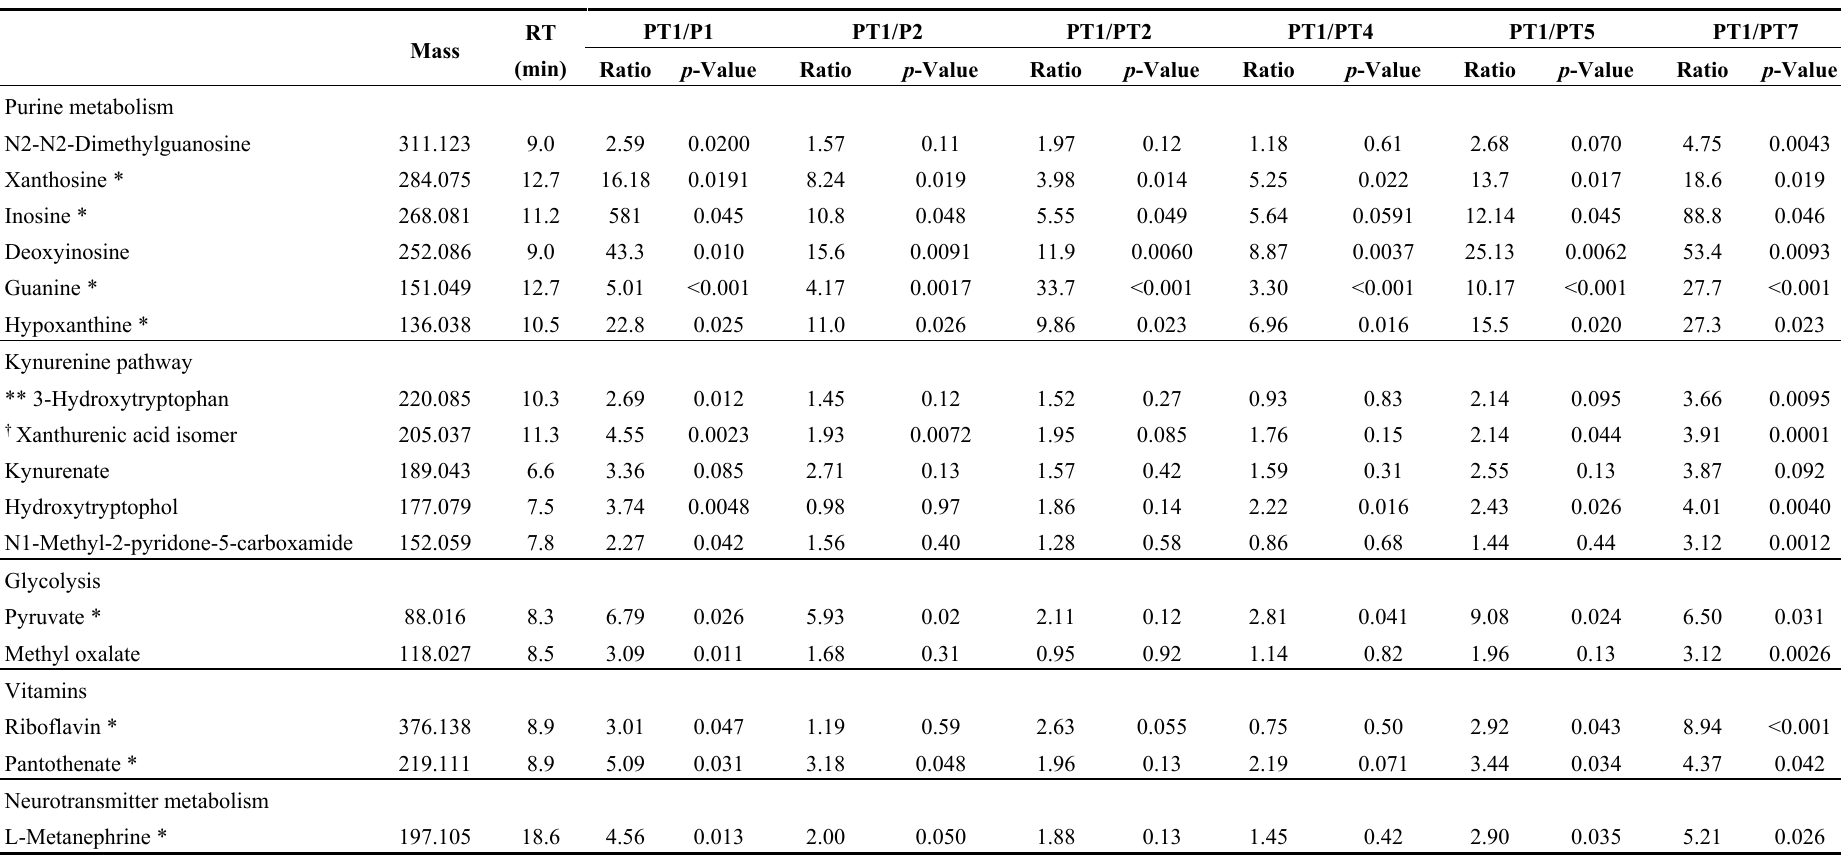
Table 2. Normalised urinary metabolites which are significantly changed by exercise for three subjects. P-value and ratio change for comparisons PT1 (first post-exercise sample) vs. P1 (pre 1), P2 (pre 2), PT4 (post 4), PT5 (post 6), PT5 (post 7) and PT7 (post 7). The majority of the metabolites match metabolites in the human metabolome to within 2 ppm and thus are characterised to MSI level 2 where alternative metabolites could be isomers of the identity